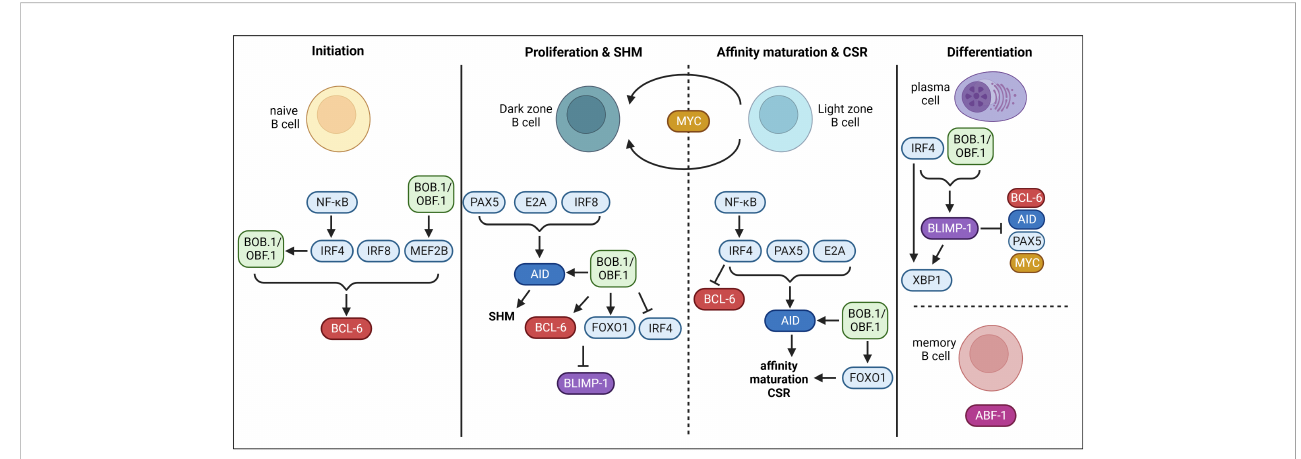
FIGURE 1 Transcriptional control of GC B cells. During GC initiation, TFs IRF4, IRF8 and MEF2B induce the expression of BCL-6. BOB.1/OBF.1 is also involved in the initiation of BCL-6 expression. Moreover, the transcriptional co-activator drives MEF2B expression. On the other hand, IRF4 seems to modulate the expression of BOB.1/OBF.1. In the dark zone, PAX5, E2A and IRF8 induce AID and therefore SHM. BOB.1/OBF.1 was also shown to be involved in AID, BCL-6 and FOXO1 induction. BCL-6 and FOXO1 inhibit BLIMP-1 and BOB.1/OBF.1 blocks IRF4 expression to prevent initiation of plasma cell differentiation at this stage. In the light zone, IRF4 is upregulated and prevents BCL-6 expression to terminate the dark zone program. IRF4, PAX5 and E2A promote AID expression and thereby af fi nity maturation and CSR. BOB.1/OBF.1 (POU2AF1) is again involved in regulation of AID and FOXO1 expression. The TF MYC probably regulates re-entry into the dark zone. IRF4 and BOB.1/OBF.1 are involved in driving BLIMP-1 expression. BLIMP-1 in turn represses BCL-6, AID, PAX5 and MYC and on the other hand facilitates expression of XBP1 together with IRF4 resulting in plasma cell differentiation. In contrast, ABF-1 induces memory B cell differentiation. This fi gure was created with